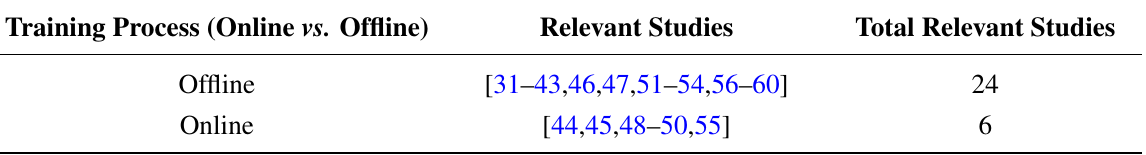
Table 2. Training process on mobile phones (online vs.